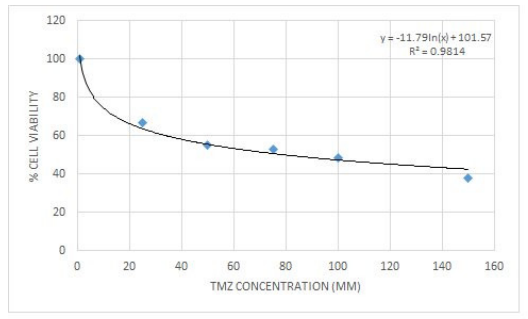
Figure 9. Cytotoxic effect of temozolomide on glioblastoma cell line U87. The IC50 value for temozolomide was calculated at 80 μΜ with an R 2 = 0.9814.